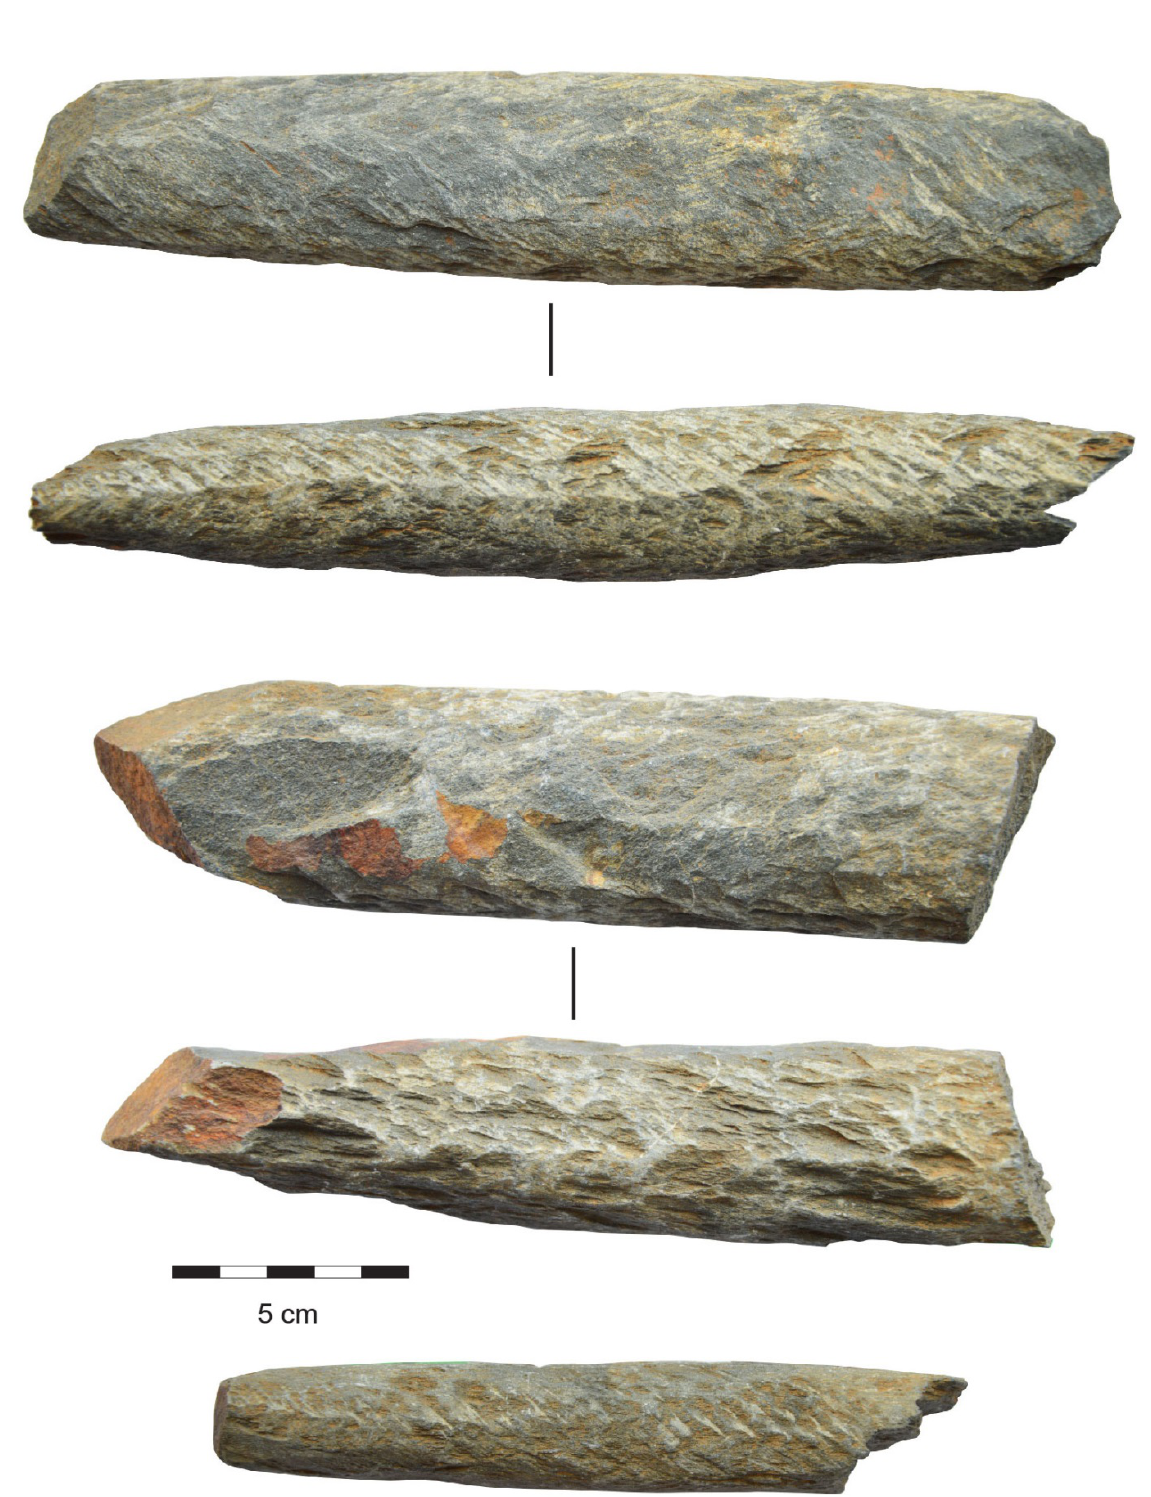
Figure 11: Cylindrical rough-outs with elliptic cross-section from Le